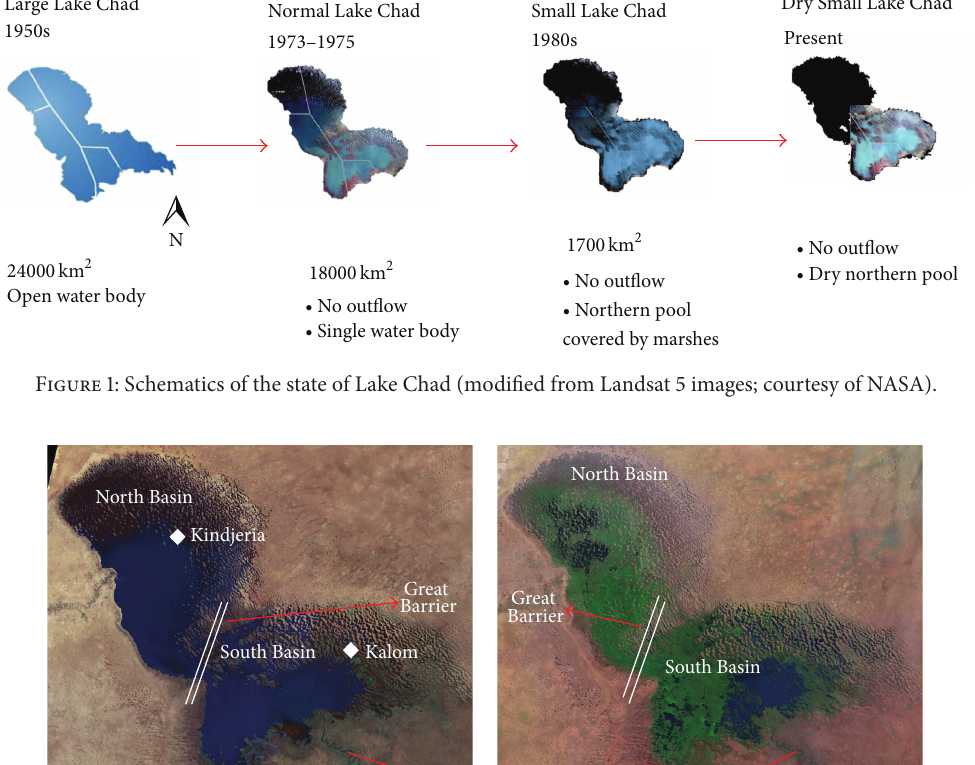
flow in the LCB [34] into the northern and southern basins,